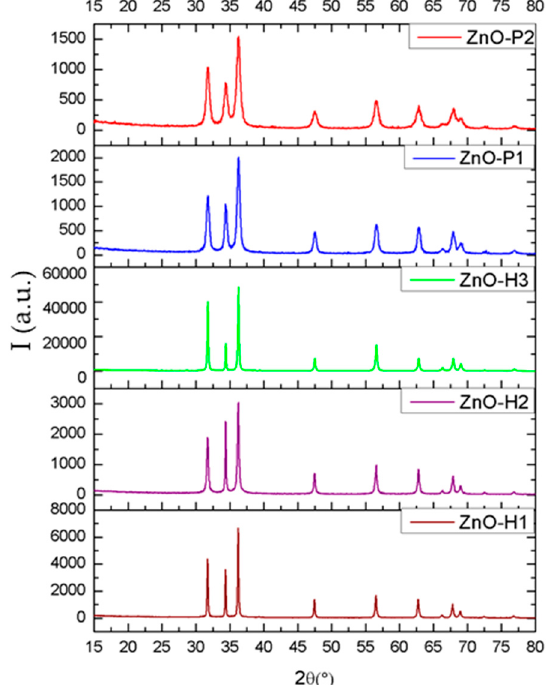
Figure 1. X-ray diffraction analysis (XRD) patterns of synthesized zinc oxide, obtained through the microwave assisted hydrothermal method (H1–H3), respectively through the polyol method (P1, P2).